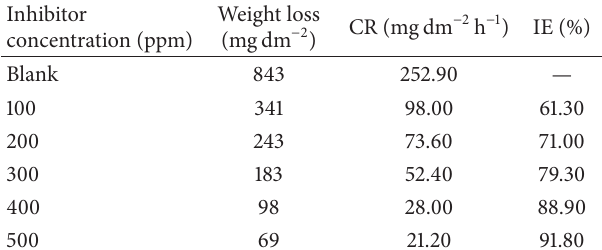
Table 1: Corrosion parameters for zinc in aqueous solution of 1.0M HCl in absence and presence of different concentrations of marjoram extract from weight loss measurements at 30 ∘ C for 1/2 h.